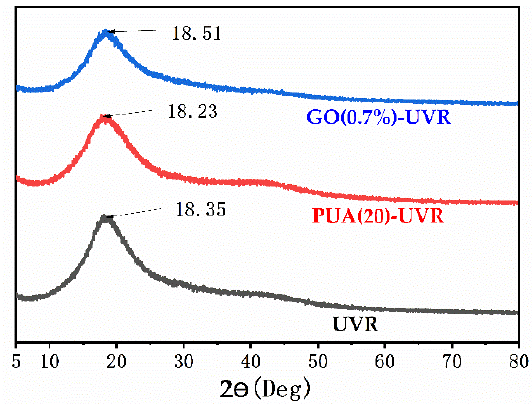
Figure 5. X-Ray Diffraction Spectra of free − radical/cationic hybrid (black), polyurethane acrylates (20%) modified (red), and graphene oxide (0.7%) modified (blue) photosensitive resins, respectively.